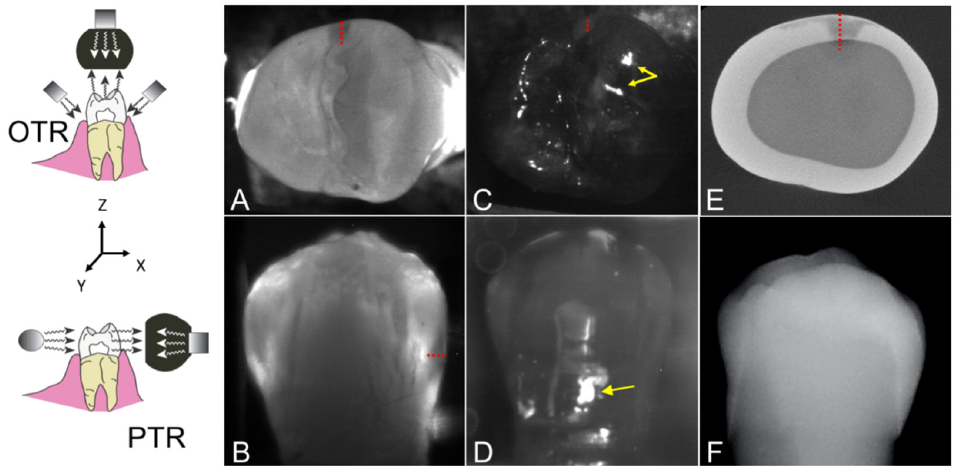
Figure 1. Diagrams of the occlusal (OTR) and proximal (PTR) dual short-wavelength infrared (SWIR) transillumination and reflectance probes used in this study. The orientation of the XYZ axes with respect to the long axis of the tooth is shown. ( A ) Occlusal transillumination image, ( B ) proximal transillumination image (buccal surface), ( C ) occlusal reflectance image and ( D ) proximal reflectance (buccal surface) image, ( E ) transverse microCT slice in the XY plane of a tooth, and ( F ) dental radiograph of a tooth with an interproximal lesion is shown. The red dotted line represents the lesion depth from the proximal surface (X direction), the green dotted line represents the lesion width (Y direction) and the blue dotted line represents the vertical distance of the lesion to the tooth occlusal surface (Z direction). The yellow arrows in the reflectance images ( C , D ) are areas of specular reflection that can potentially cause false positives.